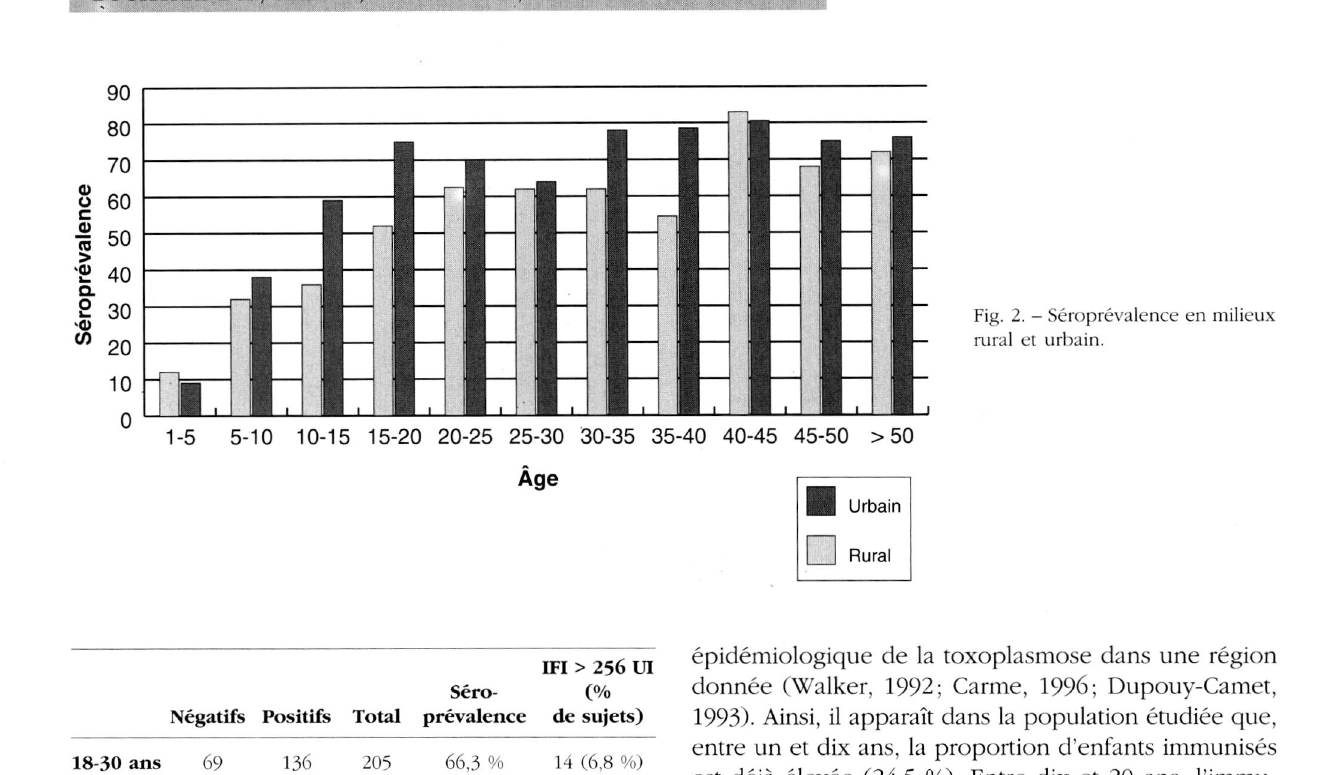
Tableau III. - Séroprévalence et proportion de sérums fortement positifs chez les femmes en âge de procréer.